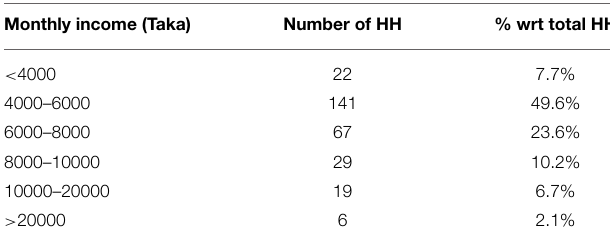
TABLE 6 | Average monthly income of the